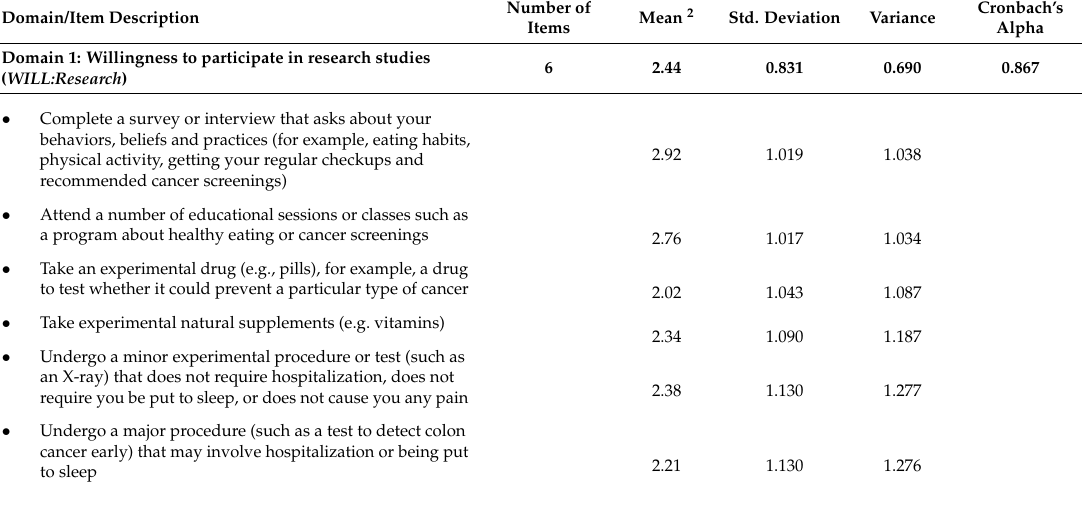
Table 1. Willingness to Participate in Cancer Research and Donate Bio-specimens (WPRDB) Scale 1 among African Americans, Latinos, and Whites in Louisiana (N =